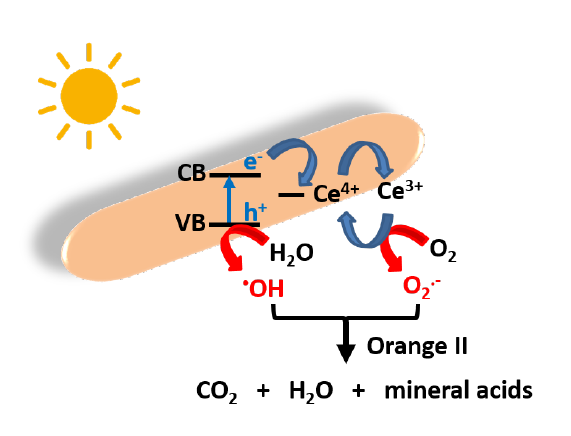
cates that O 2 • − radicals (or the species derived like hydroper- oxide HO 2 • or H 2 O 2 obtained after reaction with H + ) are the major active species in photocatalysis mediated by ZnO:Ce